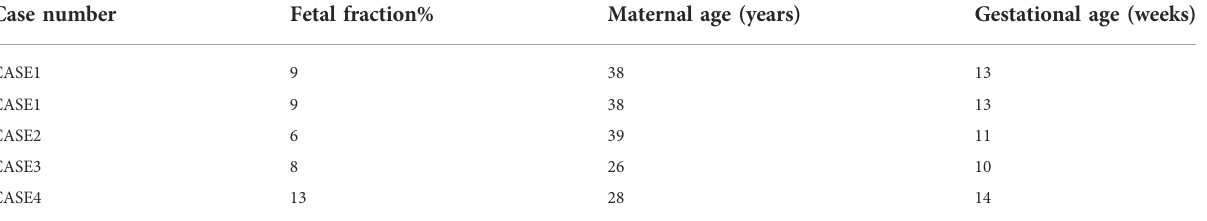
TABLE 1 General description for recruited patients.